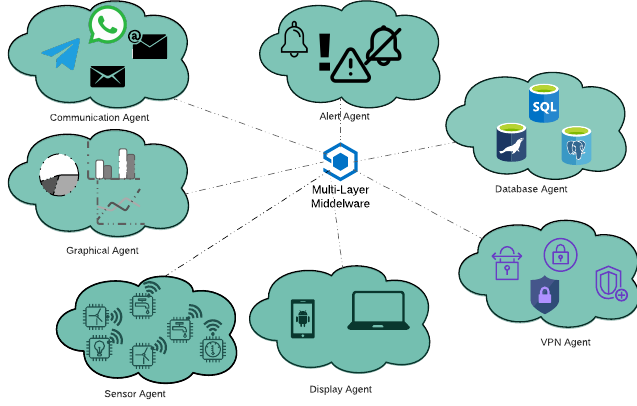
Figure 3. The middleware’s